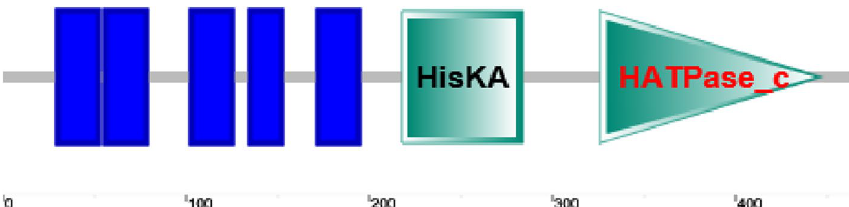
Fig. 6 Domain structure of RegB in Rhodobacter capsulatus , generated by SMART (http:// smart. embl‑ heide lberg. de/ smart/ show_ motifs. pl). RegB has a histidin kinase (HisKA) domain and HATPase_c domain. No PAS